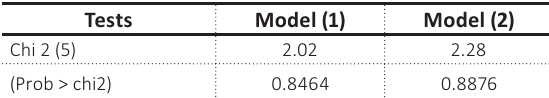
Table 8. Hausman